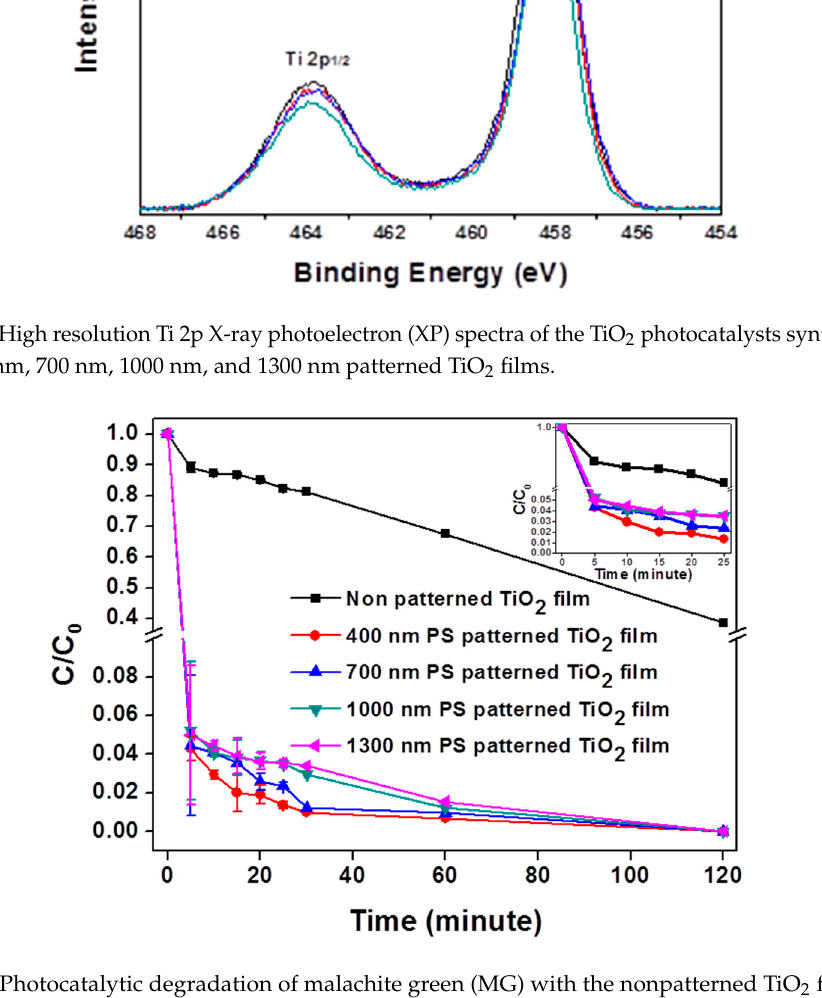
Figure 5. Photocatalytic degradation of malachite green (MG) with the nonpatterned TiO 2 film and PS-patterned TiO 2 films. Inset shows photocatalytic degradation of MG for initial 25 min.